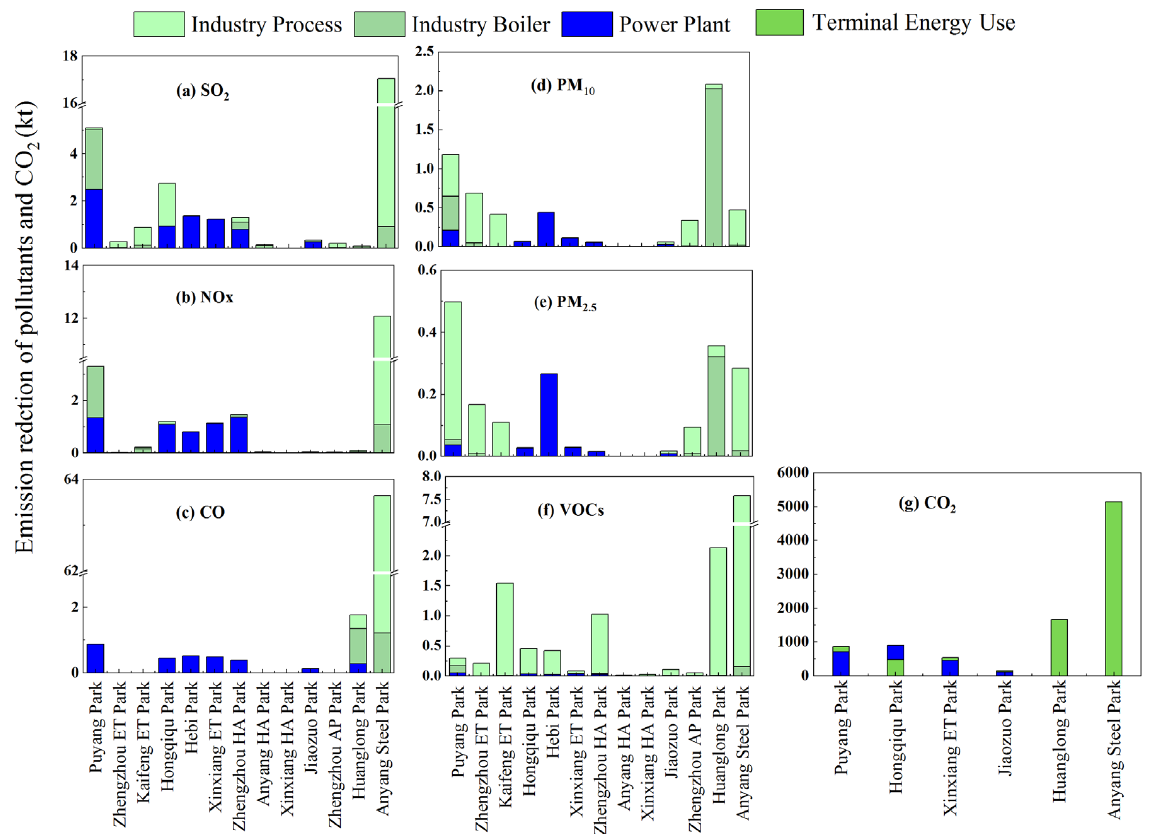
Figure 5. Emission reductions in air pollutants and CO 2 under the Green Upgrade scenario (Note: for CO 2 , Industry Process and Industry Boiler are collectively called Terminal Energy Use).